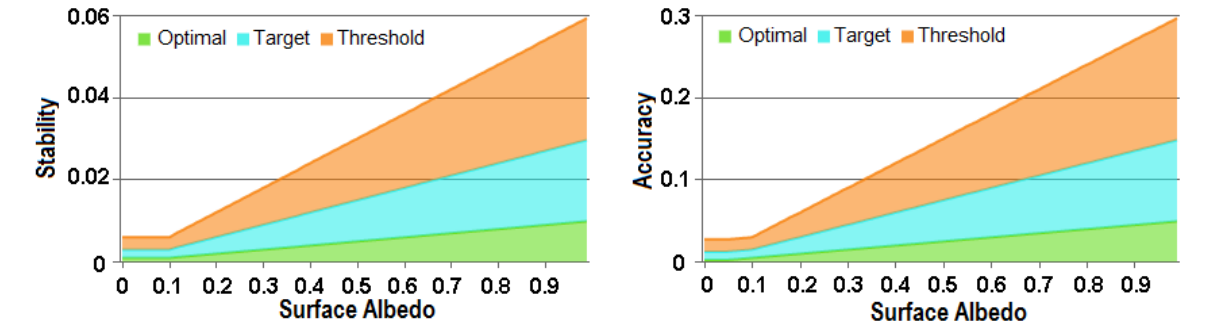
Figure 4. Stability ( left ) and Accuracy ( right ) requirement levels as a function of SA